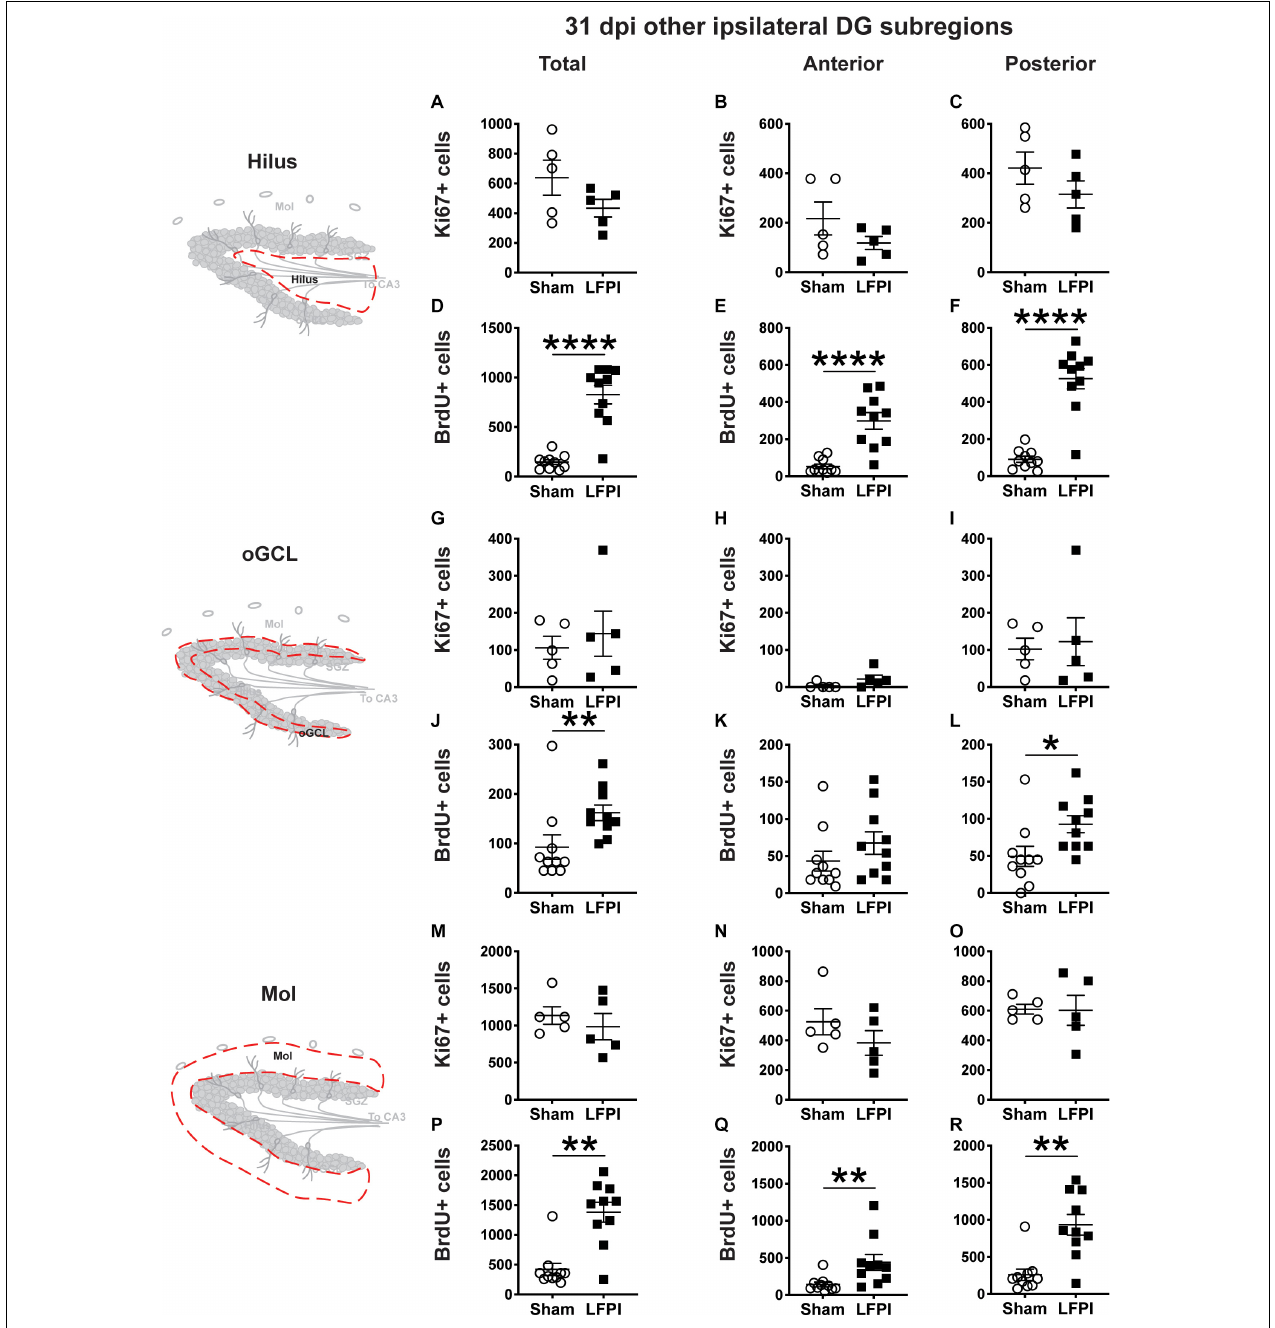
FIGURE 7 | Relative to Sham, LFPI increases the number of BrdU+ surviving cells in the ipsilateral DG hilus, posterior oGCL, and Mol 31 dpi. Stereological quantification of Ki67+ ( A–C,G–I,M–O ; Sham n = 5, LFPI n = 5) and BrdU+ ( D–F,J–L,P–R ; Sham n = 10, LFPI n = 10) cells in the hilus ( A–F ; red dotted line region, top-left schematic), outer granule cell layer ( G–L ; red dotted line region, middle-left schematic), and molecular layer ( M–R ; red dotted line region, bottom-left schematic). Immunopositive cells were quantified across the entire longitudinal axis (A,D,G,J,M,P) , and also broken up into anterior (B,E,H,K,N,Q) and posterior (C,F,I,L,O,R) bins, operationally defined as Bregma levels − 0.92 to − 2.6; and − 2.6 to − 3.97, respectively. T-test, * p < 0.05, ** p < 0.01, and **** p < 0.0001.